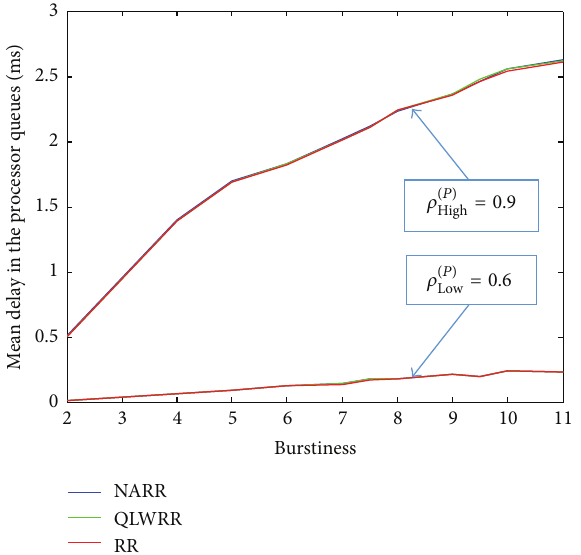
Figure 11: Mean off- and on-states duration of the traffic on the out- put